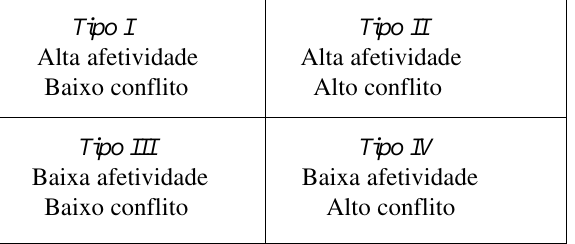
Figura 1 . Classificação de tipos de família de acordo com os construtos afetividade e conflito do